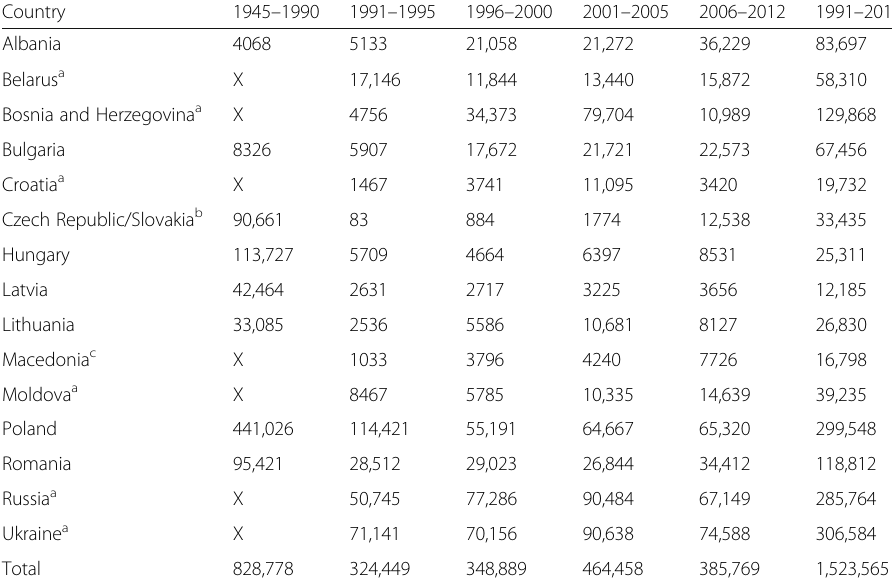
Table 1 Trends in Eastern European immigration by country of birth, 1991 – 2012